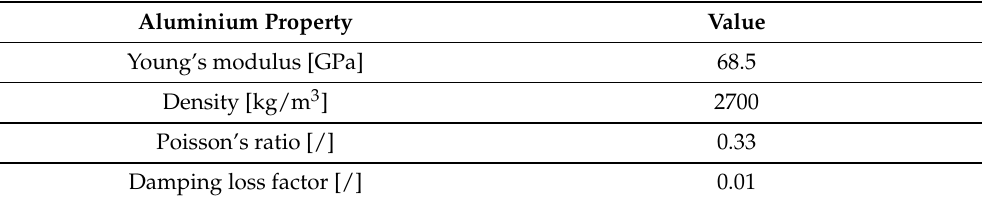
Table 1. Mechanical characteristics of the aluminium. Aluminium Property